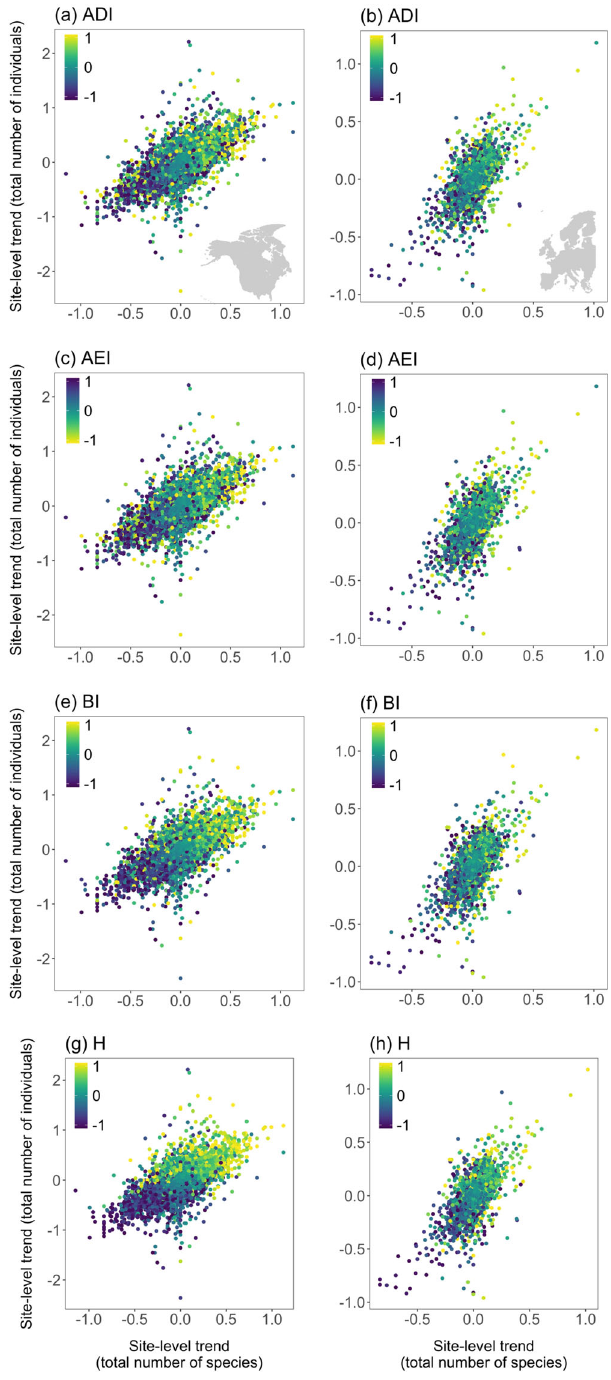
Fig. 5 Trends in community structure and soundscape characteristics. The association between site-level in trends in the total number of species and the total number of individuals in 202737 NA-BBS sites across North America (left column) and in 16524 PECBMS sites across Europe (right column). Colours indicate site-level trends in Acoustic Diversity Index, ADI ( a , b ), Acoustic Evenness Index, AEI ( c , d ) Bioacoustic Index, BI ( e , f ) and Acoustic Entropy, H ( g , h ) (yellow — improving soundscape quality; blue — declining soundscape quality); note the colour scheme is reversed for AEI, as positive trends are taken to represent a reduction in soundscape quality for this metric. Site-level trends are derived from changes in standardised annual values of each acoustic index, total number of species, and total number of